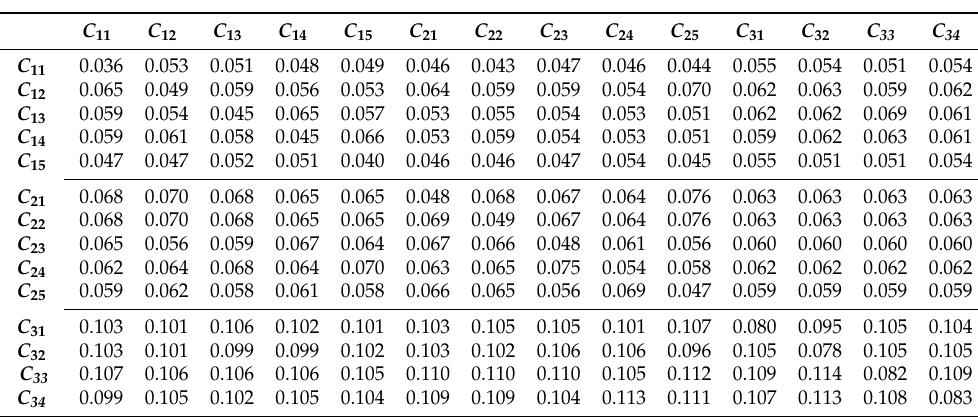
Table A2. DEMATEL-adjusted initial supermatrix W adj